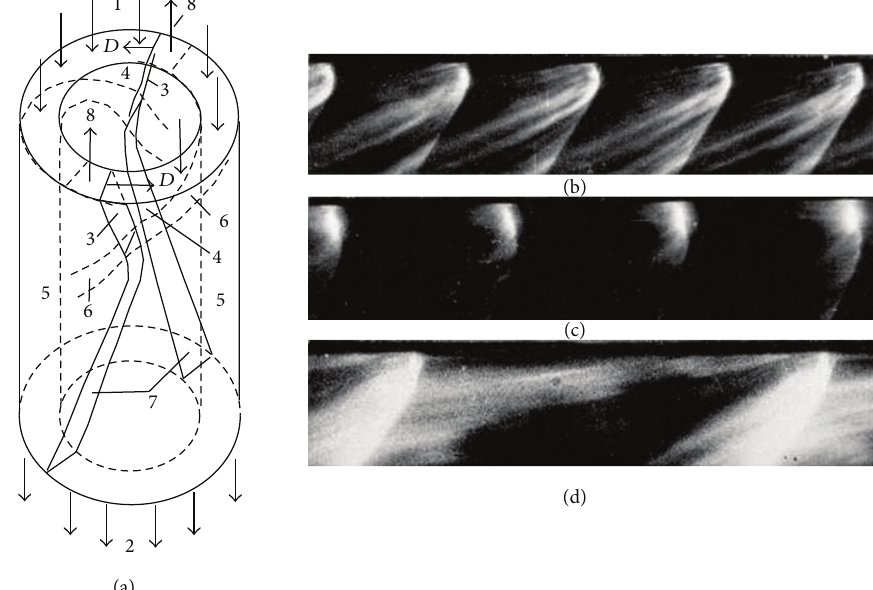
Figure7:Theschemaofcontinuousburningofamixtureintheflowingringcombustionchamberandtypicalstreakrecordsofself-luminosity of rotating DW at registration across slit paralleled to axis.